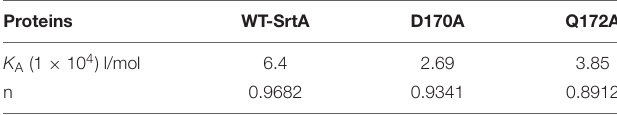
TABLE 2 | The values of the binding constants ( K A ) based on fluorescence quenching assay. Proteins WT-SrtA D170A Q172A